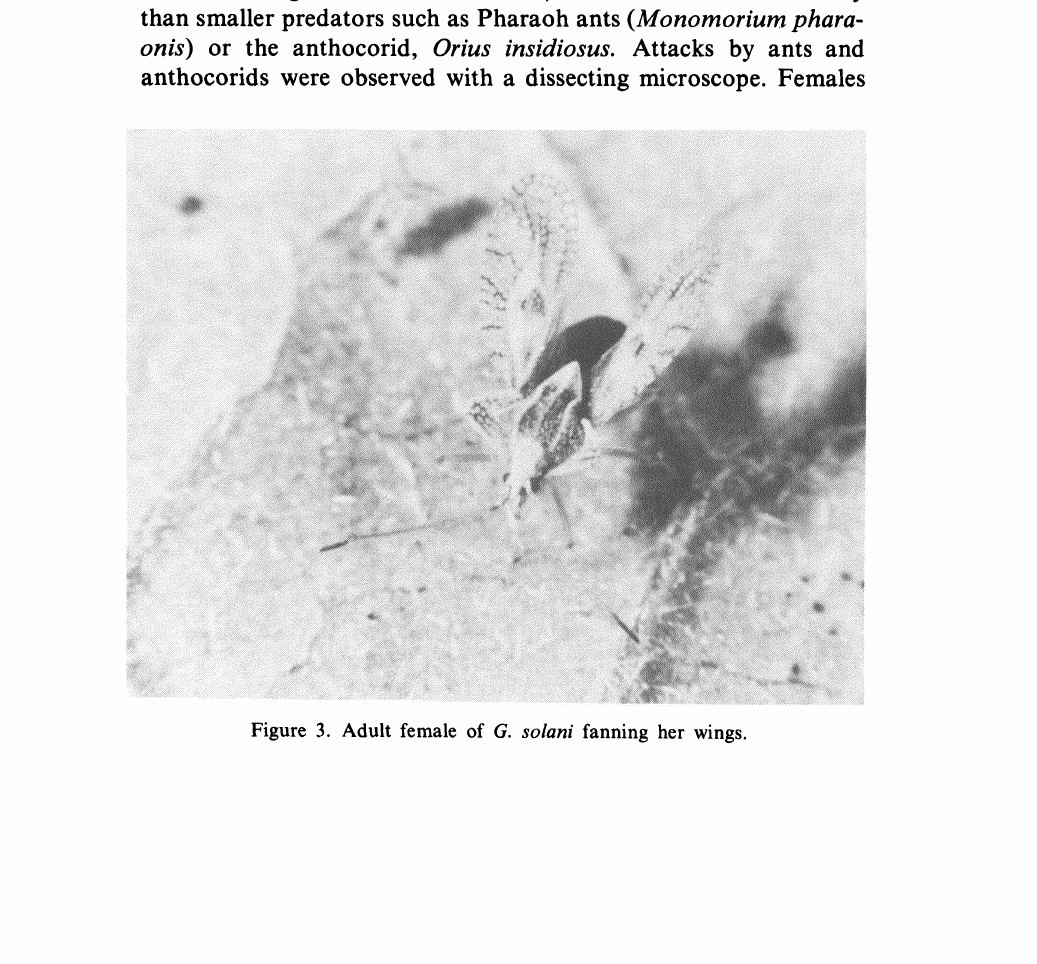
Figure 3. Adult female of G. solani fanning her